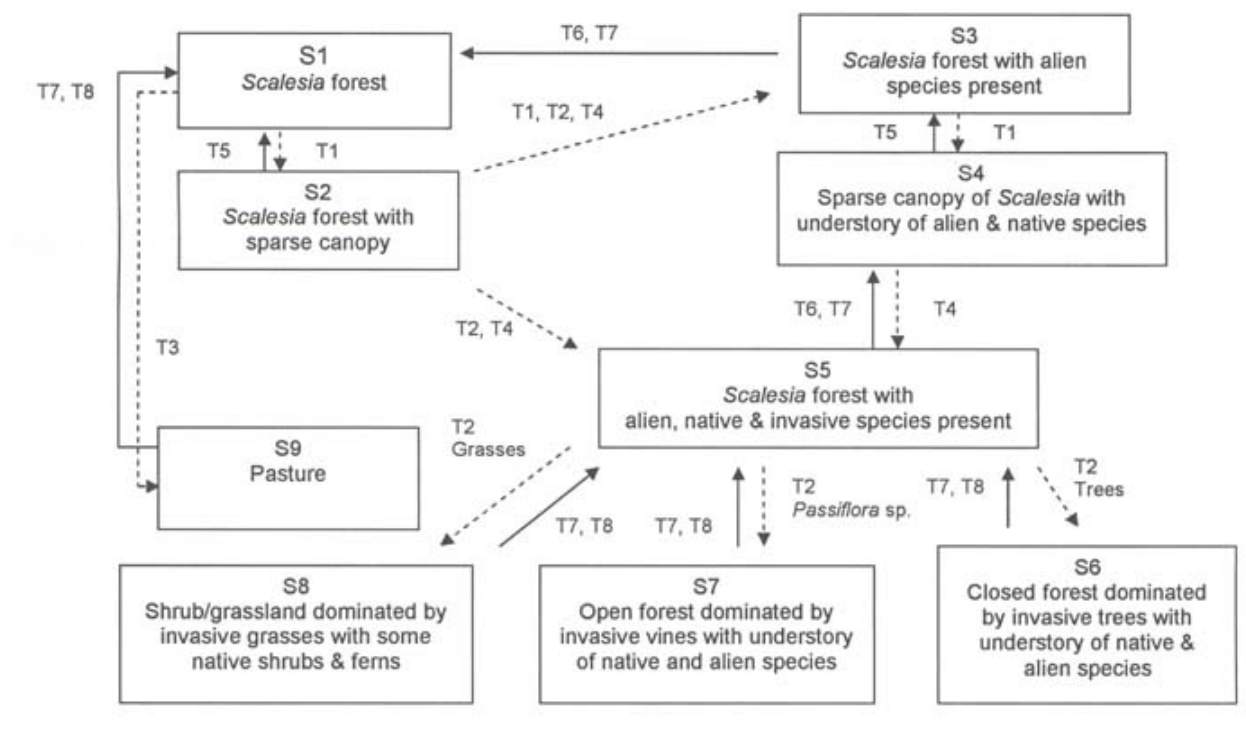
Fig. 2. State-transition model for restoration of Scalesia pedunculata forest within Galapagos National Park. Lines and arrows indicate transitions (T) between states (S); dotted lines indicate those that are obstacles to restoration; and solid lines those that provide opportunities for restoration. Key to transitions: T1–forest canopy gaps; T2–limited resources for management; T3–direct clearing of forest; T4–unrestricted access to forest; T5–natural regeneration; T6–special protection status for Scalesia forest; T7–management of alien plants and animals; T8–native propagule